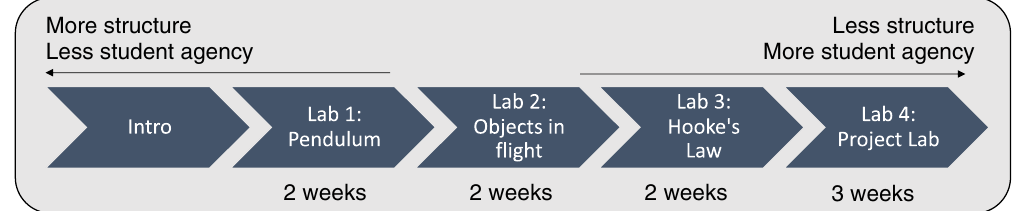
FIG. 1. The diagram shows the timeline of the lab units in the courses. Available student agency increases and structure decreases as students proceed from lab unit 1 to lab unit 4 (Project lab).